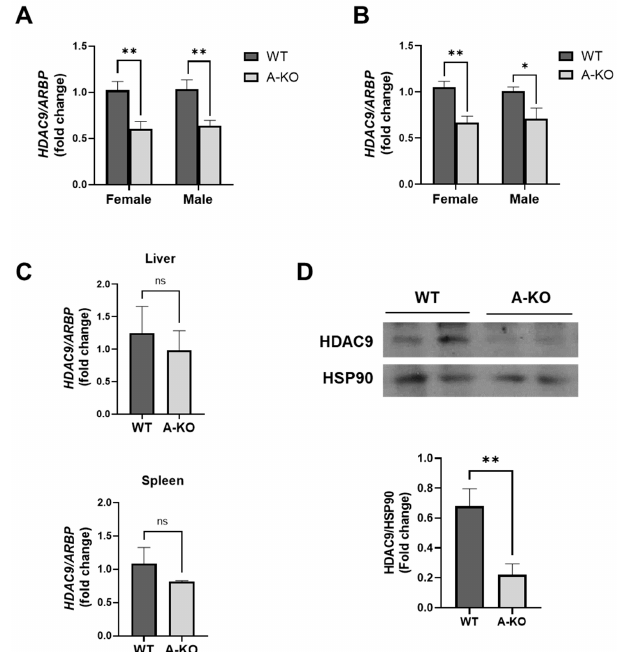
Figure 2. Generation of adipocyte-specific HDAC9 KO mice. HDAC9 mRNA expression in SQ ( A ) and VF ( B ) from male and female HFD-fed mice ( n = 5 – 9). ( C ) HDAC9 mRNA expression level in tissues from female WT and A-KO fed a HFD ( n = 4). ( D ) Western blot validation of HDAC9 protein expression in VF from HFD-fed female mice ( n = 6). Data represent mean ± SEM. * p < 0.05, ** p < 0.01, ns, not significant. A-KO, adipocyte-specific HDAC9 KO; SQ, subcutaneous adipose tissue; VF, visceral adipose tissue.